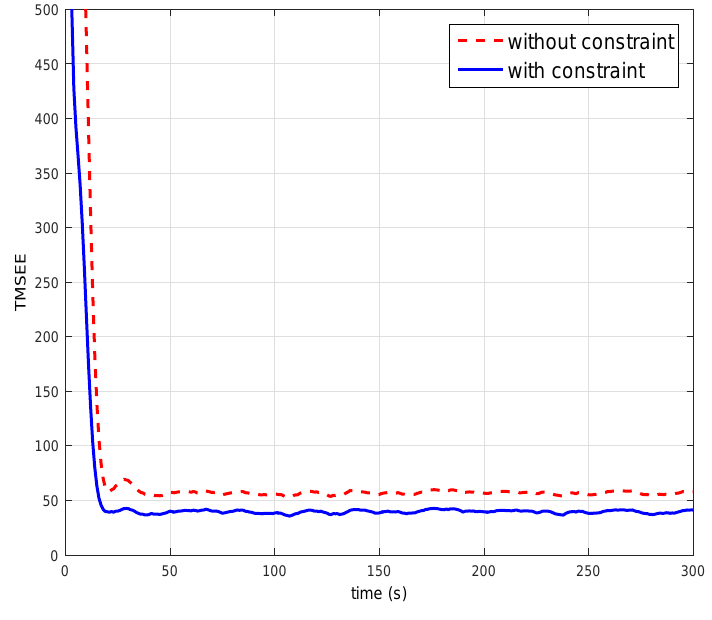
Figure 2. Comparison between RSKCF and